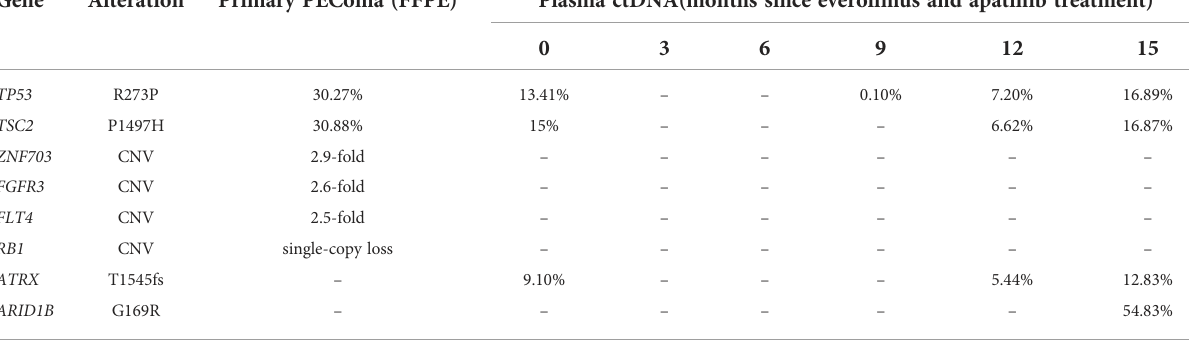
TABLE 1 The allele frequencies of genetic alterations detected by targeted NGS in the primary PEComa tumor and serial plasma ctDNA. Gene Alteration Primary PEComa